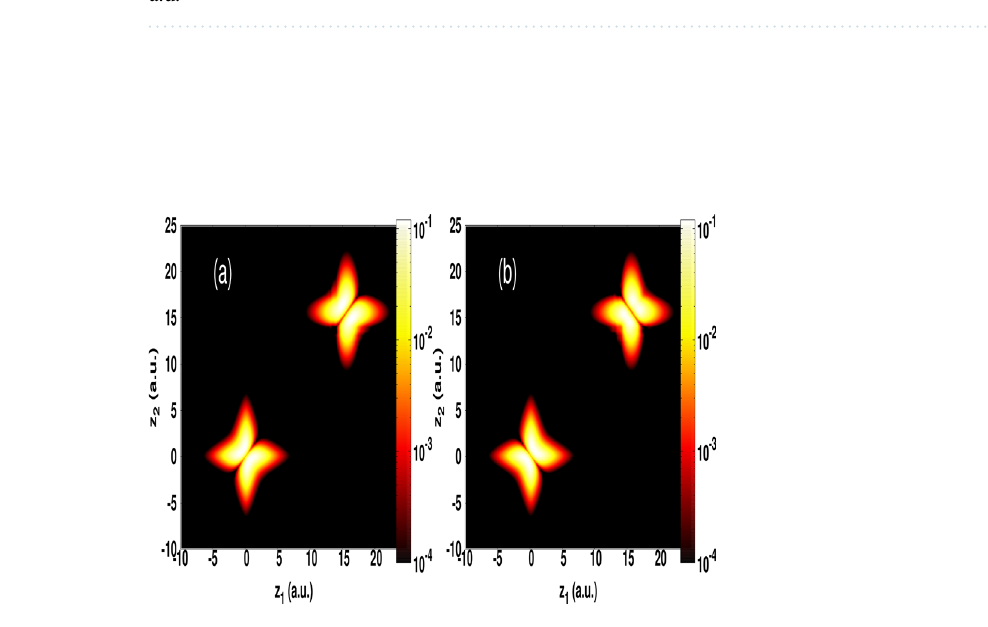
Figure 3. Illustration of a coherent transport of an electron wavepacket initially localised in a chain of four sites. Upper panel: Schematic diagrams showing the transport of the electron between neighbouring sites and back to the initial one. Lower panel: Electron density in the ρ – z plane for the transported electron state using four subsequent single-cycle pulses. The peak intensity is fixed at 1.31 10 22 W/cm 2 and angular frequency is 6 a.u.